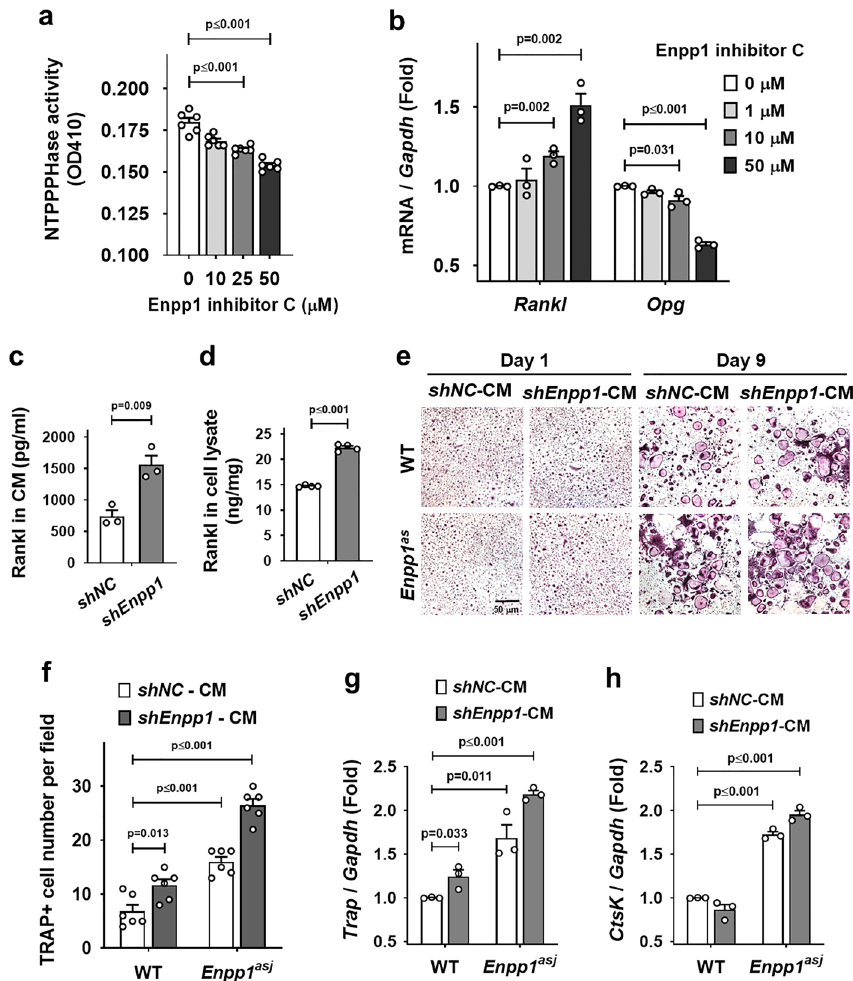
Figure 4. Inactivation of Enpp1 induces Rankl expression in cementoblasts. ( a ) NTPPPHase activity was analyzed with OCCM-30 cells after treatment with Enpp1 inhibitor C for 2 h as indicated (n = 6). ( b ) Transcript levels of Rankl and Opg were analyzed by real-time qPCR (n = 3). RNA was isolated from OCCM-30 cells treated with Enpp1 inhibitor C for 24 h. ( c ) The protein amount of soluble Rankl was measured by ELISA using conditioned media (CM) from the culture of OCCM-30 cells with shEnpp1 and shNC (n = 3). ( d ) The protein amount of Rankl was measured by ELISA using whole cell lysates from OCCM-30 cells with shEnpp1 and shNC (n = 4). ( e ) TRAP staining was performed with BMMs from WT and Enpp1 asj mice. BMMs were differentiated for 9 days with conditioned media (CM) from the culture of OCCM-30 cells supplemented with M-CSF (20 ng/ ml) but without recombinant Rankl for 9 days. Scale bar are indicated. ( f ) TRAP-positive multinucleated cells were randomly counted in the field of the microscope of ( e ) at day 9 (n = 6). ( g , h ) Transcript levels of Trap and CtsK were analyzed by real-time qPCR (n = 3). RNA was isolated from BMMs differentiated in the same condition with ( f ). Significance was assigned with p values as indicated in each